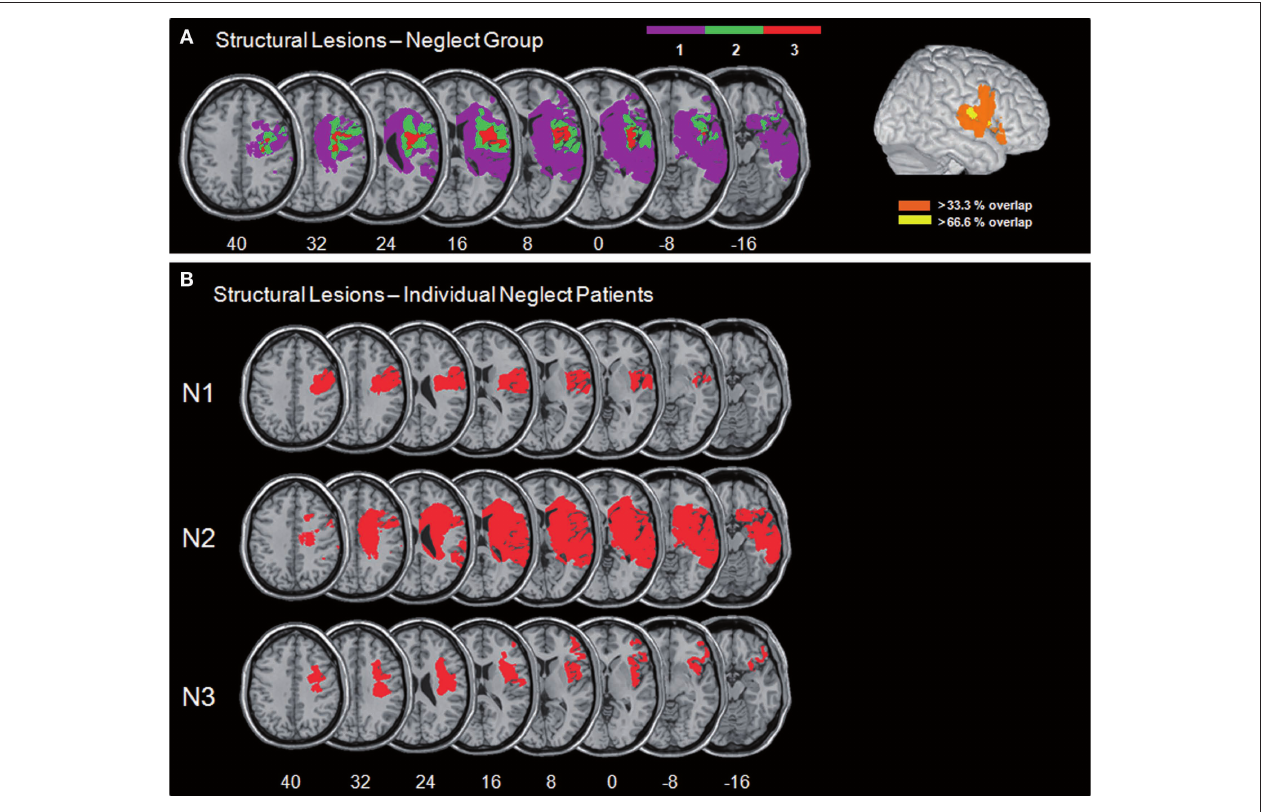
> 33.3% indicates that with respect to our sample at least two patients had lesioned tissue in this area and > 66.6% indicates that all patients had a lesion in this area. (B) Normalized DWI/FLAIR lesions for individual patients with spatial neglect. MNI z-coordinates of the transverse sections are